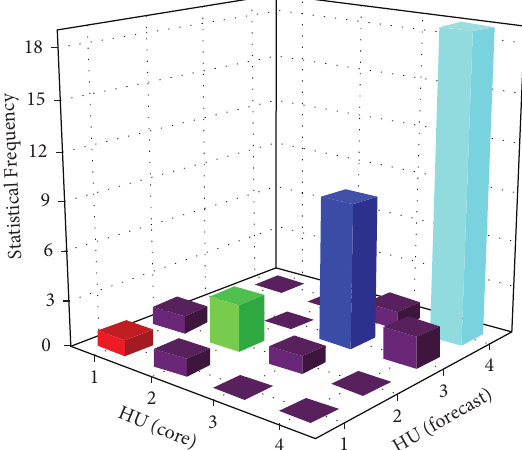
Figure 6: Statistical frequency of HU